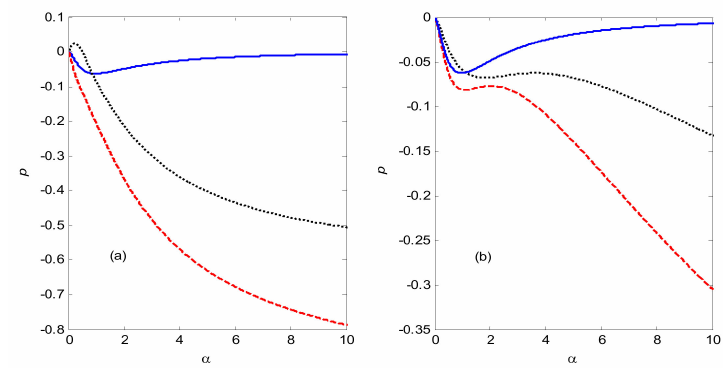
Figure 6. The Pearson correlation coe ffi cient p as a function of α = Γ r / Γ l . ( a ) Γ l = Γ 0 and ( b ) Γ l = 0.2 Γ 0 . The blue solid line is constructive ( η = 1), red dashed line is destructive ( η = − 1), and black dotted line is η = exp ( i π /2 ) . δε = Γ 0 , α =